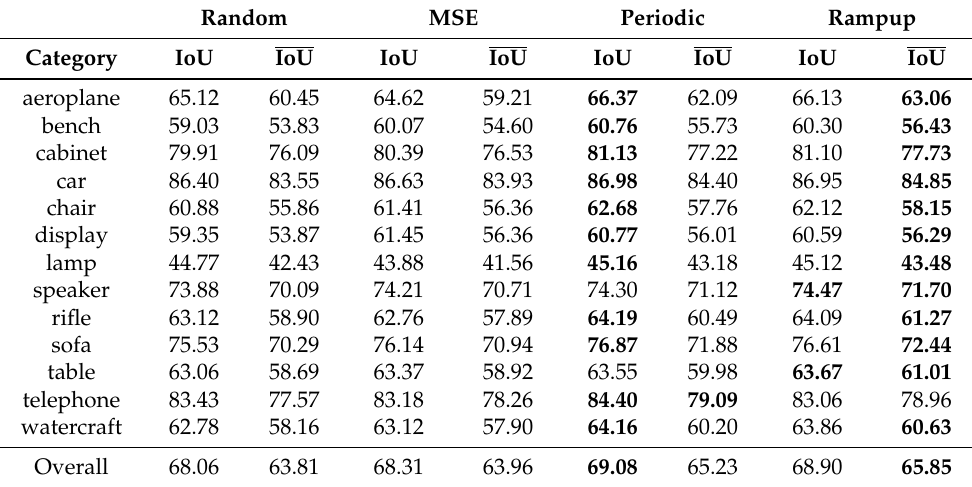
Table 7. Results for different selection techniques. We report both the IoU and the IoU averaged over the full test set for 8-view reconstruction in %. We highlight in bold the highest achieved IoU and IoU per category and